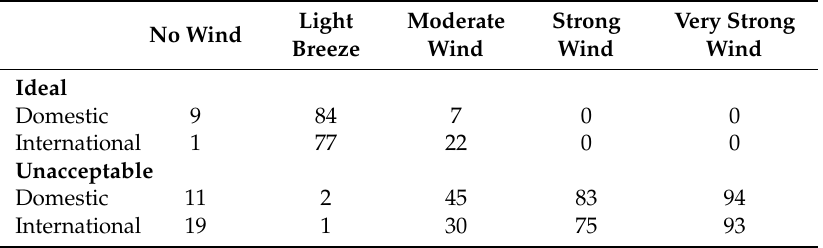
Table 2. Ideal and unacceptable daily wind conditions (% of